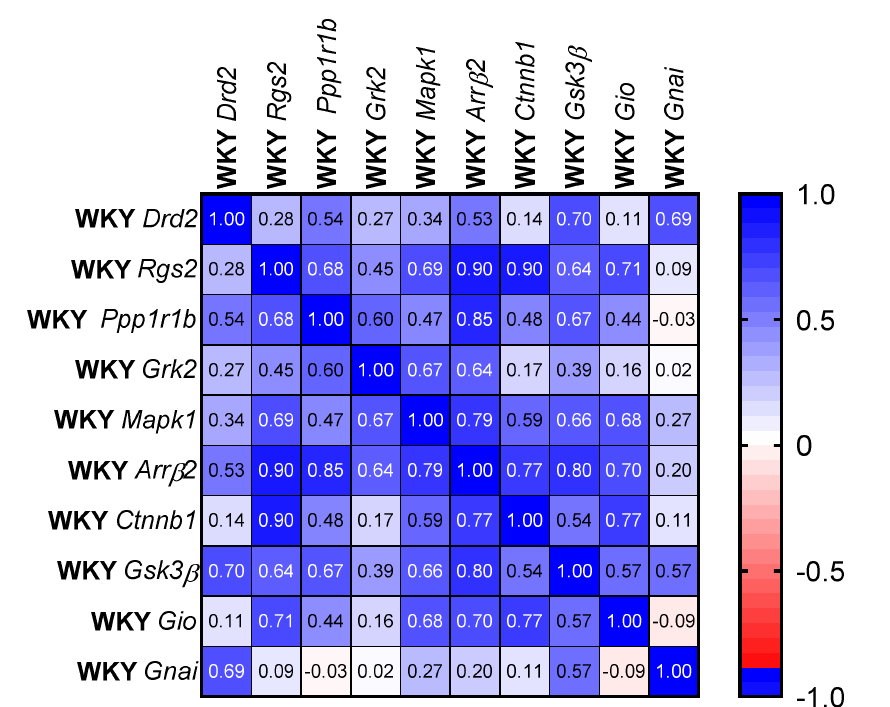
Figure 3. A correlation matrix with Pearson’s r coefficient. Abbreviations: WIS—Wistar Han and WKY—Wistar-Kyoto.